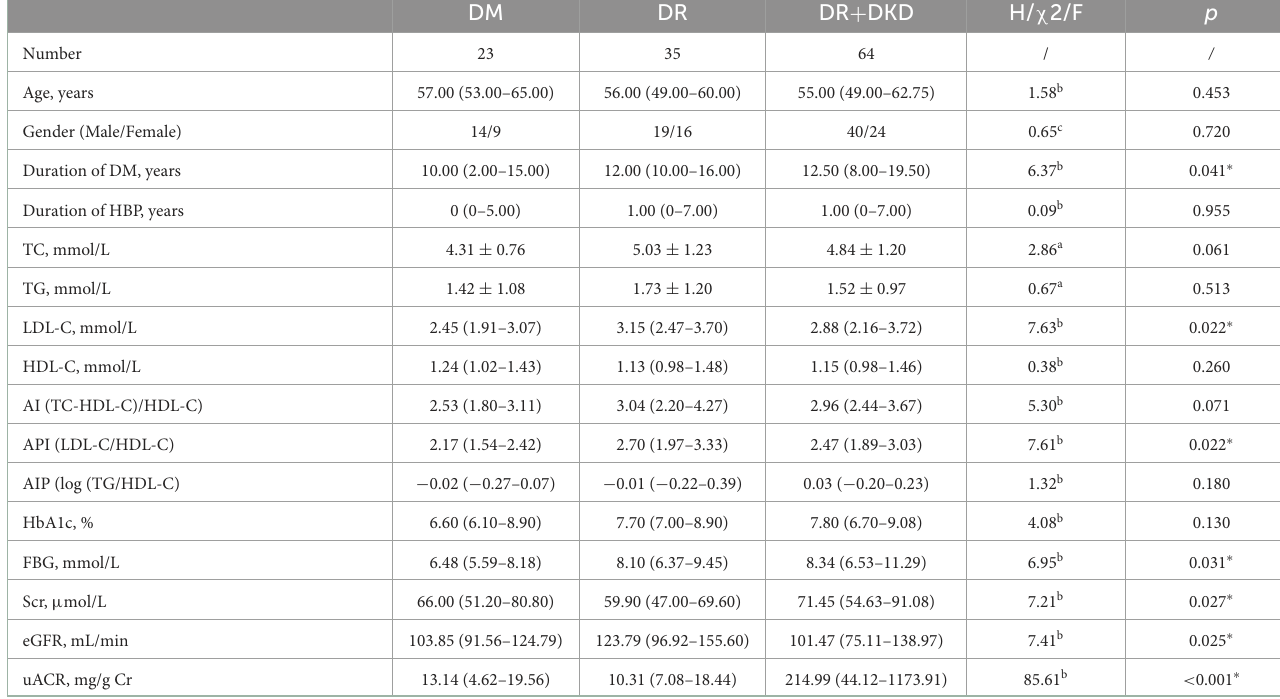
TABLE 1 Comparison of baseline demographic and clinical characteristics in subjects with DM, DR, and DR + DKD.